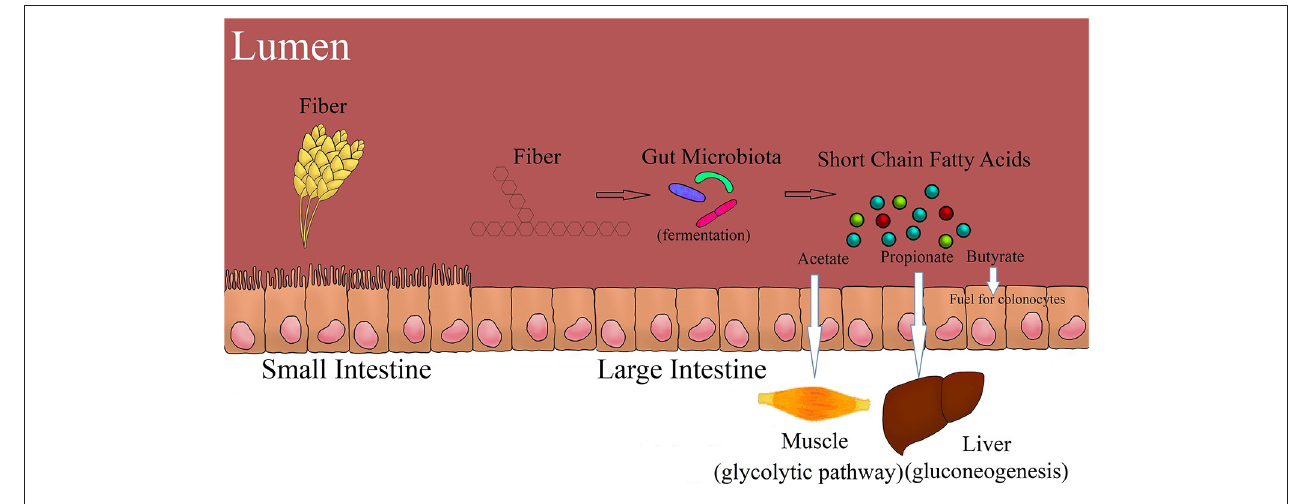
FIGURE 2 | Fiber fermentation and its primary utilization